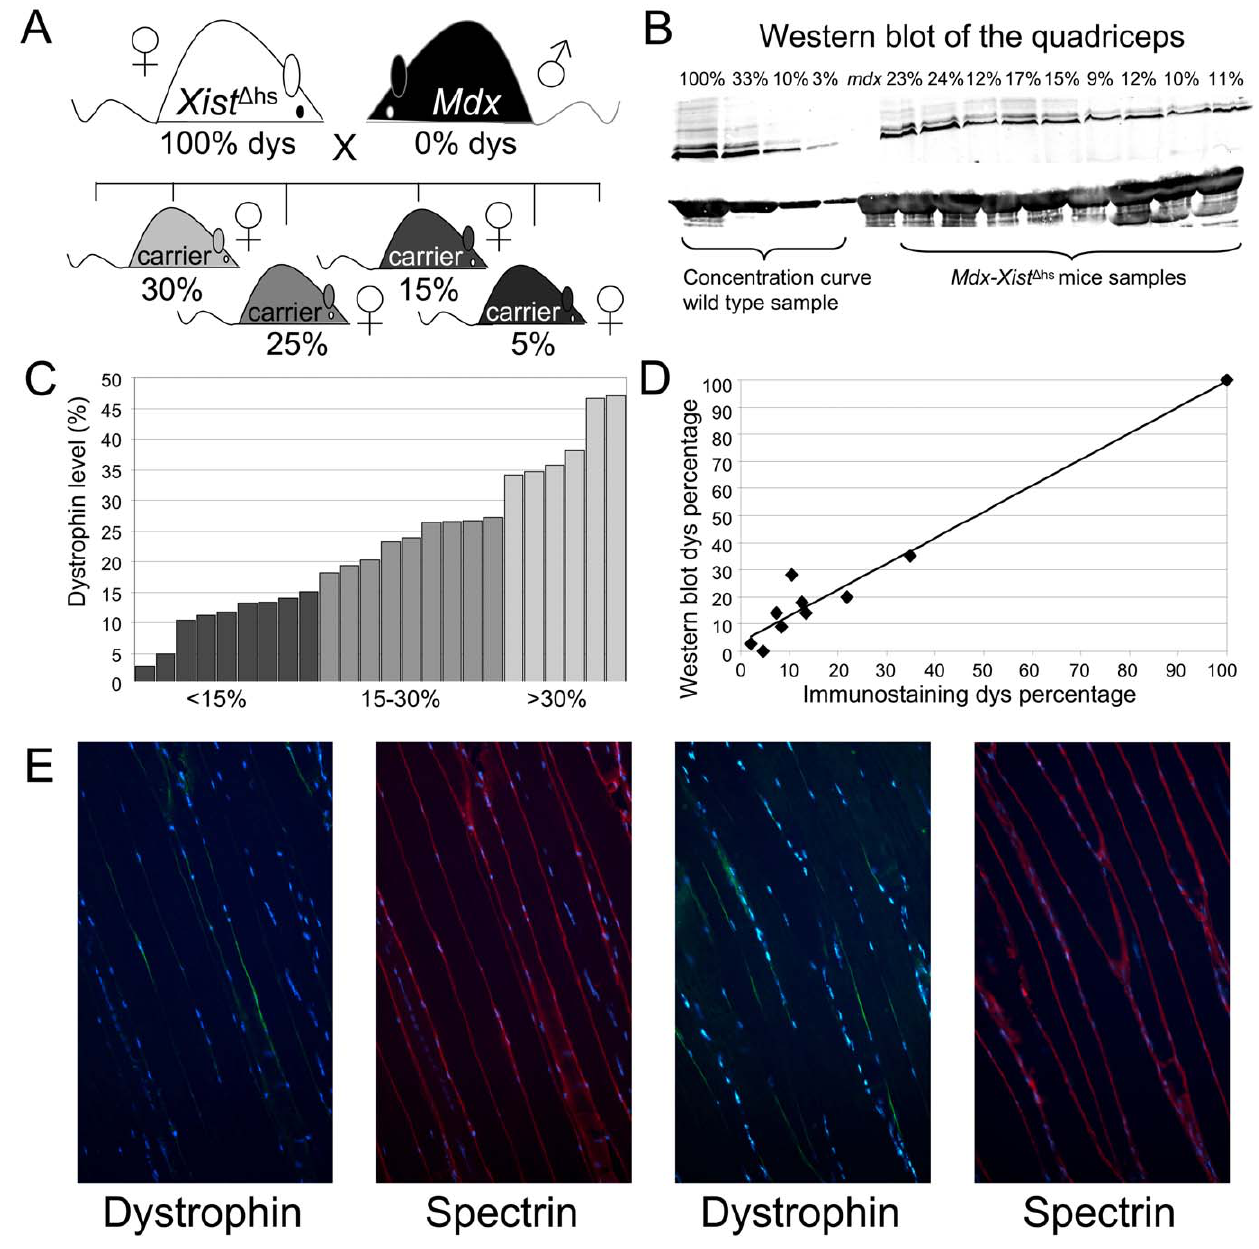
Figure 1. Mdx-Xist D hs mice. A. To breed mice with low dystrophin levels, female Xist D hs mice, carrying a mutation in the Xist promoter which coordinates X-inactivation, were crossed with dystrophin negative mdx males. During embryogenesis, the maternal X-chromosome encoding a functional dystrophin gene will be preferentially (60–90%) inactivated as a result of the mutated Xist promoter. The Xist D hs mice were a kind gift from N. Brockdorff (MRC Clinical Sciences Center, London, UK, current affiliation Department of Biochemistry, University of Oxford, UK). B. Picture of a representative Western blot. The percentage of dystrophin was determined for the quadriceps of all mdx-Xist D hs mice by Western blot (2–9 technical replicates per mouse). The percentage of individual mice was determined using a concentration curve made from wild type samples. Myosin was used as a loading control. C. Skewed X-inactivation resulted in dystrophin levels of 3–47% (mean 22.7, stdev 12.1, n =24) (as determined by Western blot) in the female mdx-Xist D hs offspring. Each bar represents the dystrophin level of an individual mouse. The dystrophin levels of the individual mice belonging to the three dystrophin groups can be appreciated from this graph. D. Dystrophin levels determined by Western blot and manual counting of dystrophin positive fibers demonstrate a strong correlation (R=0.97). E. Longitudinal sections of a quadriceps stained with dystrophin (green) and spectrin (red). From the pictures it can be appreciated that dystrophin expression is not homogeneously expressed across the fiber but rather confined to certain nuclear domains. significantly ( P , 0.001) heavier at the end of the functional test increased weight compared to wild type has been described before regime than the other mouse strains (mean weight 26, 24.5 and for mdx mice [34]. Xist D hs mice had a stable body weight from week 11 onwards, while the other models showed a mild increase over 18.2 gram for mdx , mdx - Xist D hs and Xist D hs , respectively). An